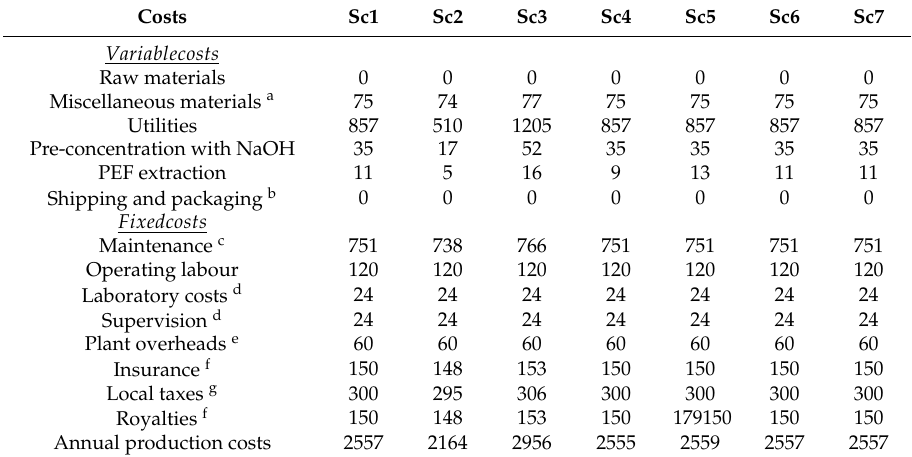
Table 8. Estimation of the annual production costs (in k€) in each of the studied scenarios (Sc).